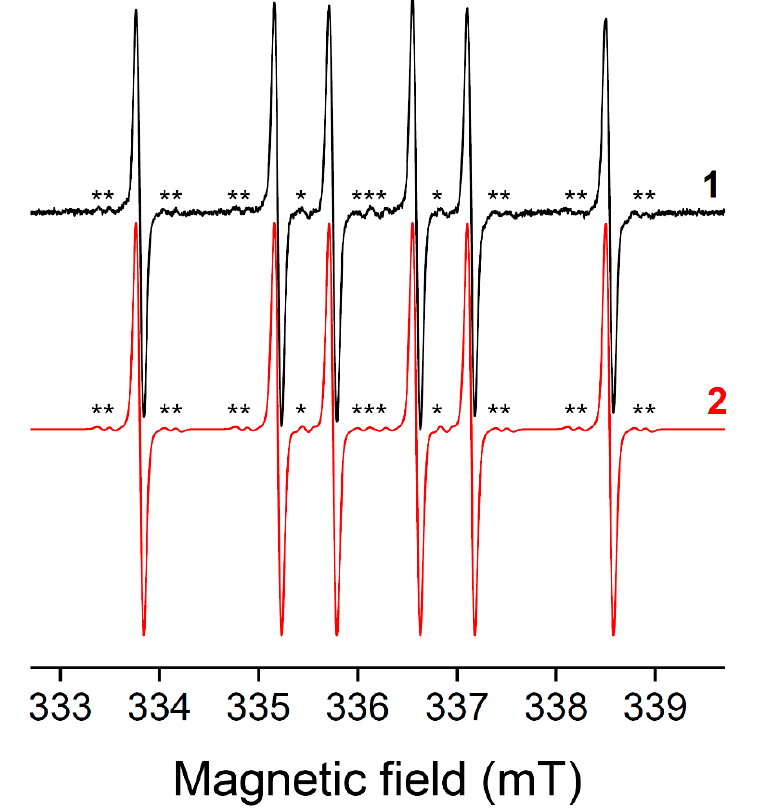
Figure 9. Experimental (1) and simulated (2) EPR spectra of the (4-methyl)phenyl radical spin adduct of DMPO obtained upon LED irradiation at 400 nm of allylated purpurin and Iod in benzene under argon. Satellite lines due to hyperfine coupling to 13 C are indicated with asterisks. Reproduced from Ref. [35]. Copyright 2021 permission Royal Society of Chemistry.